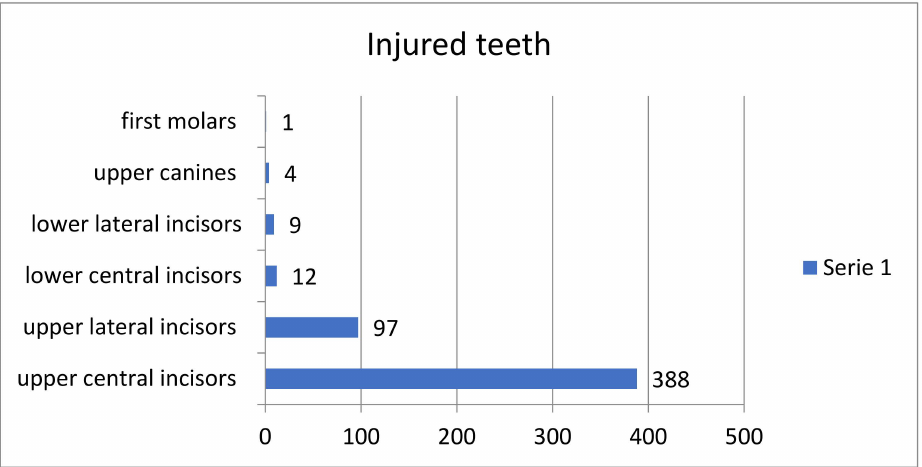
Figure 2. Injured